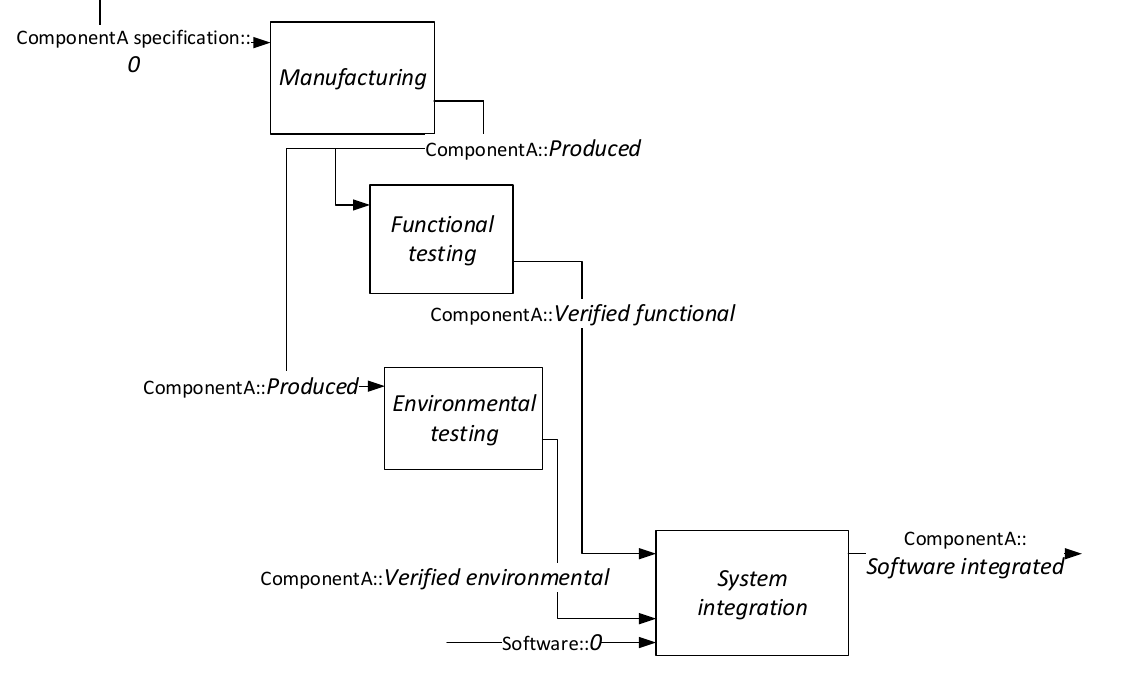
Figure 12. Process description modeled PROVE.